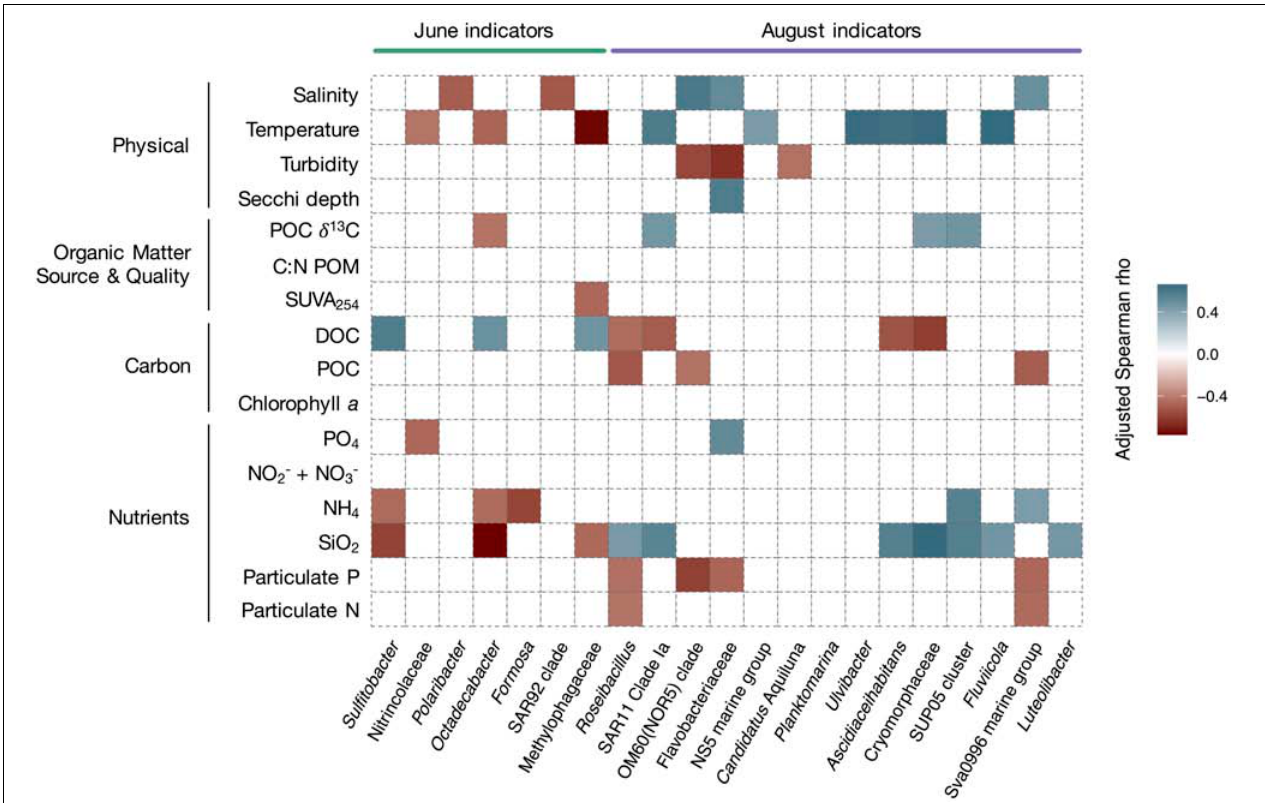
FIGURE 7 | Heatmap showing significant Spearman correlations (adjusted Spearman rho) between relative abundance of seasonal indicator taxa and Isfjorden physico-chemical variables. The indicators for the two months were statistically retrieved using the indicspecies package in R (IV ≥ 0.7, p ≤ 0.001). A regression was done between the relative abundance of the indicator taxa and the environmental variables using individual data. The sampling month is indicated above the plot and the taxonomic affiliations are indicated beneath the plot. Relevant indicators were chosen among highly abundant indicators and are ordered by decreasing abundance for each month. For a full overview of indicator species, see Supplementary Table 6 . Only significant correlations are shown. A blue color indicates a positive correlation and a red color indicates a negative correlation. p -values were FDR-corrected with the BH